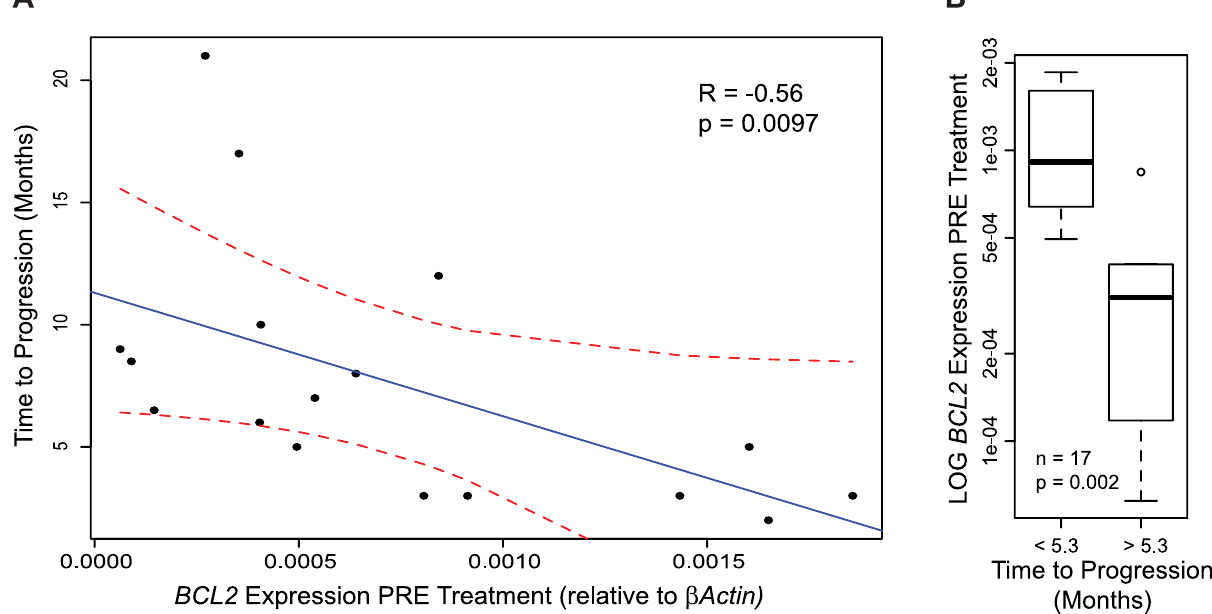
Figure 1. Pre treatment BCL-2 expression in tumors of patients with metastatic melanoma negatively correlates with response to BRAF inhibition. ( A ) Linear regression between duration of patient response to BRAF inhibition and BCL-2 expression levels relative to endogenous gene b Actin prior to treatment (n=17, R= 2 0.56, p=0.0097, dotted red lines indicate 95% confidence intervals). ( B ) Patients who progress in less than 5.3 months have higher levels of BCL2 mRNA expression relative to b Actin pre-treatment than patients with an above average duration of response to BRAF inhibition (P # 0.05).